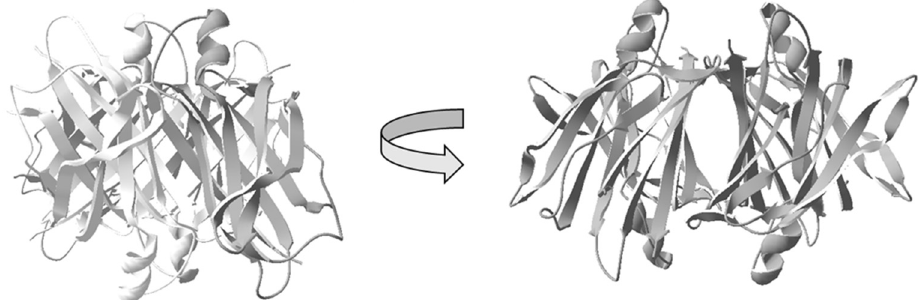
Figure 1. Schematic illustration of the native homotetrameric structure of transthyretin (TTR) [44]. The image illustrates the four subunits assembled to form a hydrophobic central channel amenable for binding of the thyroxine hormone T4, as well as analogs.